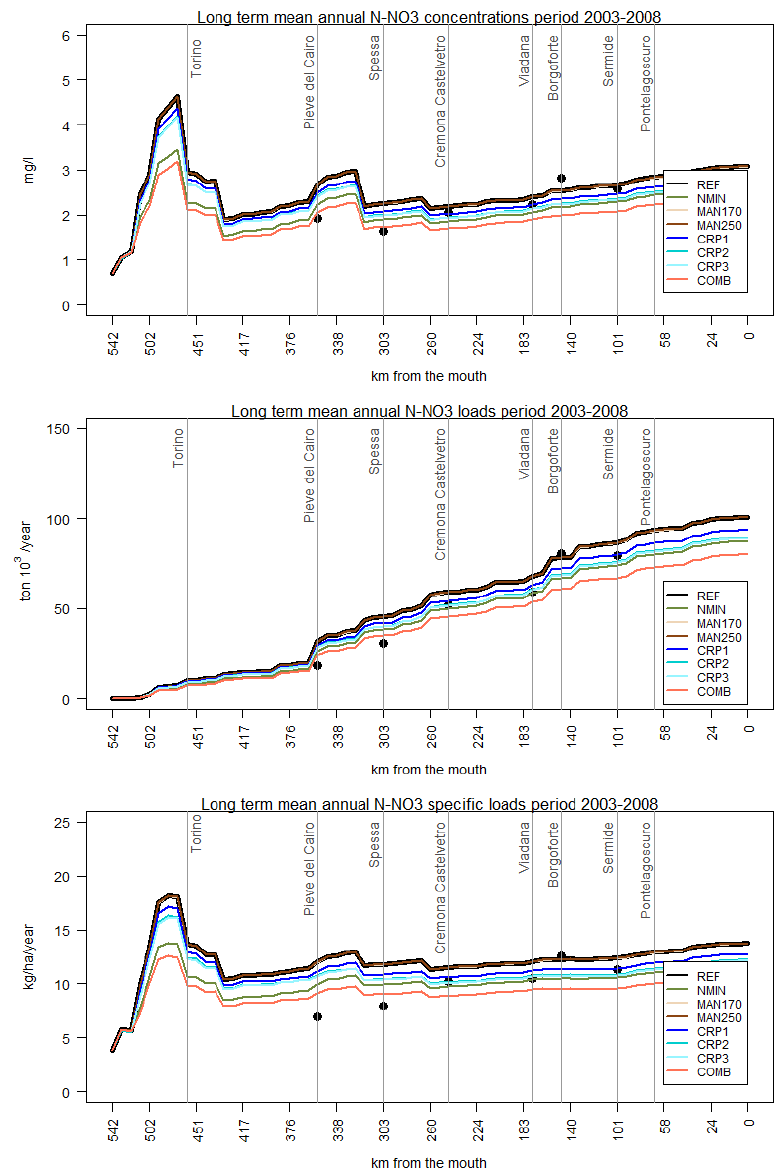
Figure 9. Comparison of simulated long-term mean annual N-NO 3 concentrations and loads in the period 2003–2008 (where observations are concentrated) as function of the distance from the mouth. The black dots represent the long term mean annual observations calculated in the period 2003–2008.